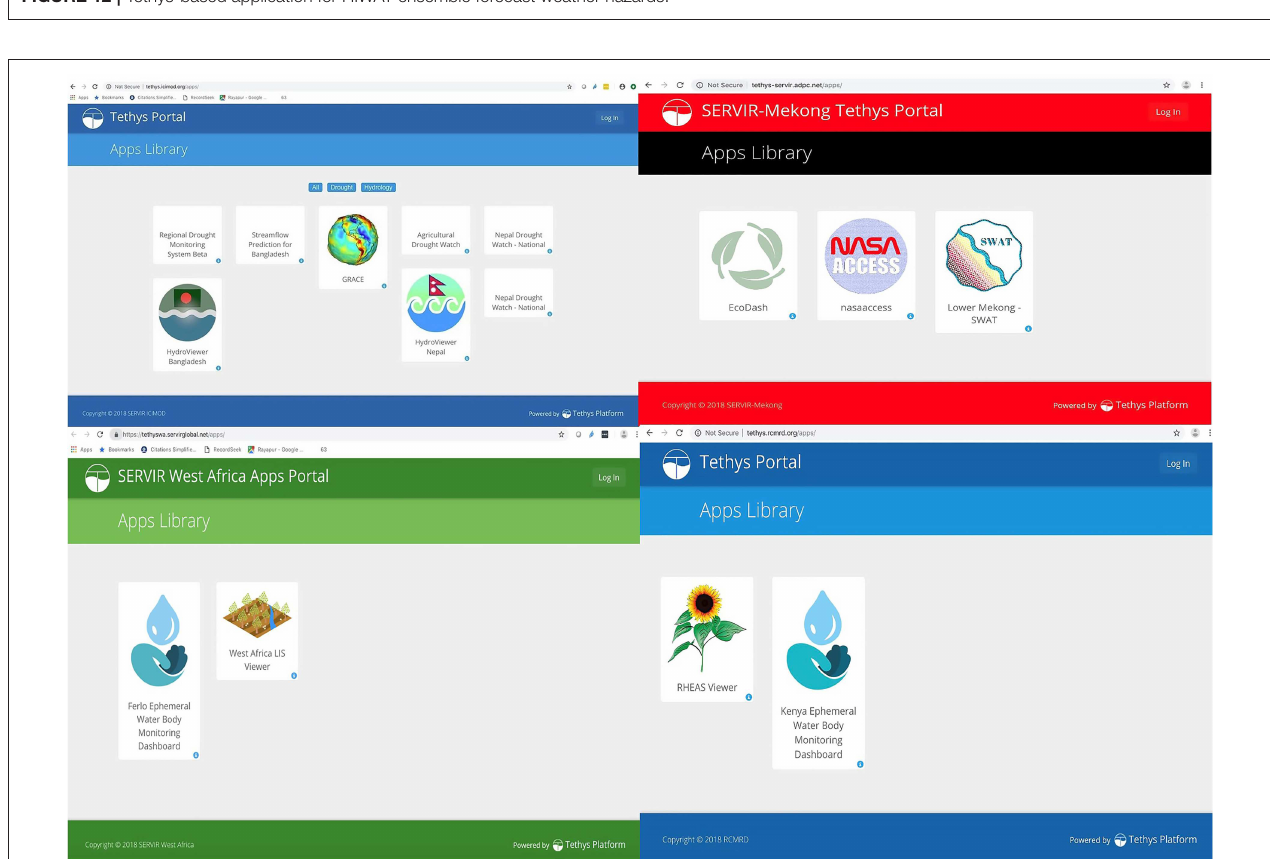
FIGURE 13 | Tethys portals for SERVIR regional hubs. (top left) ICIMOD http://tethys.icimod.org/apps (top right) ADPC http://tethys-servir.adpc.net (bottom left) AGRHYMET (bottom right) http://tethys.rcmrd.org.